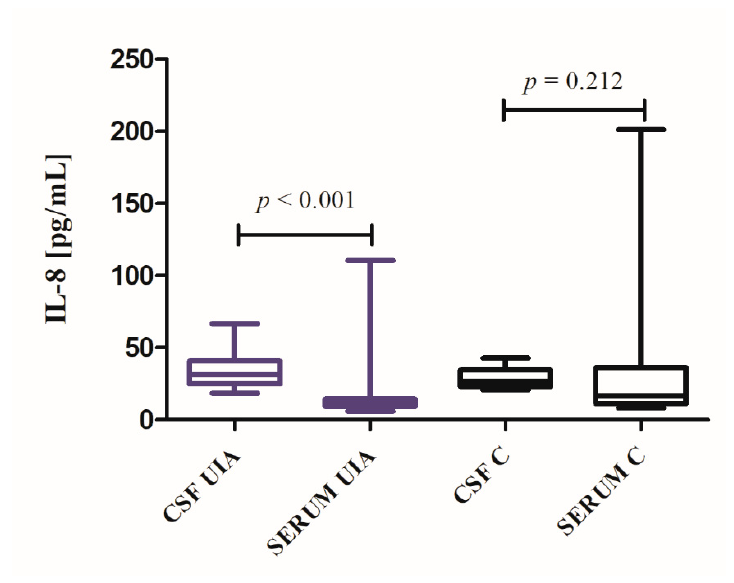
Figure 1. IL-8 cerebrospinal fluid (CSF) and serum concentrations in unruptured intracranial aneurysm (UIA) patients compared to control group (C).